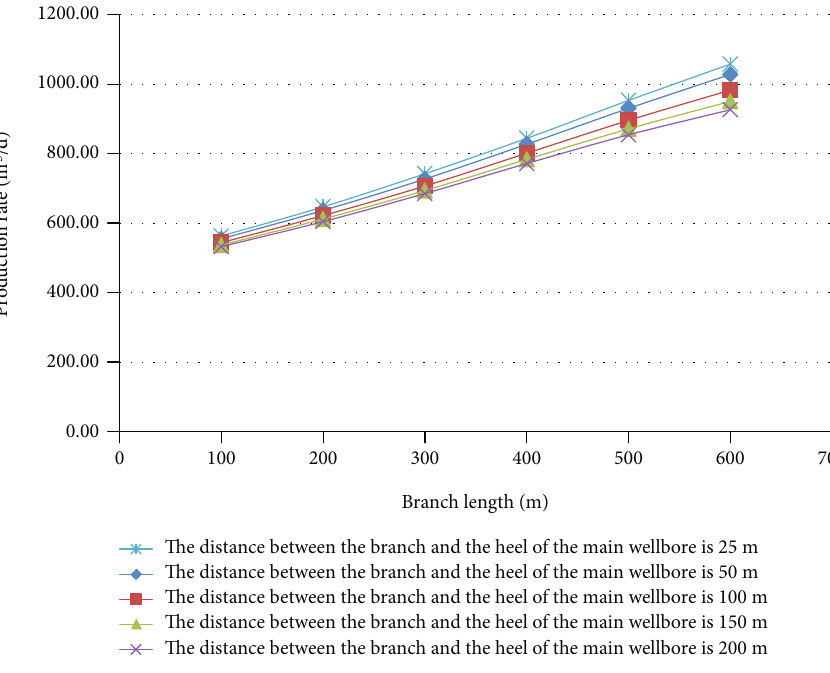
Figure 8: Production with di ff erent branch